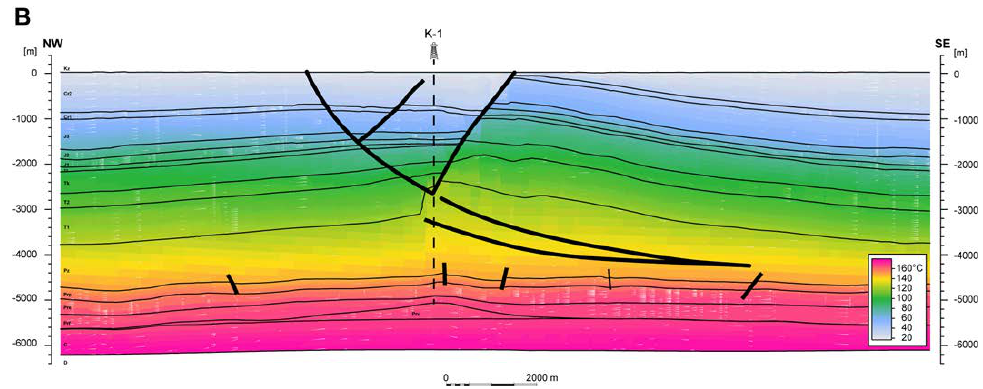
Figure 12. Distribution of the temperature along the NW–SE cross-sections: ( A ) upper part, SMV1; ( B ) lower part, SMV2.